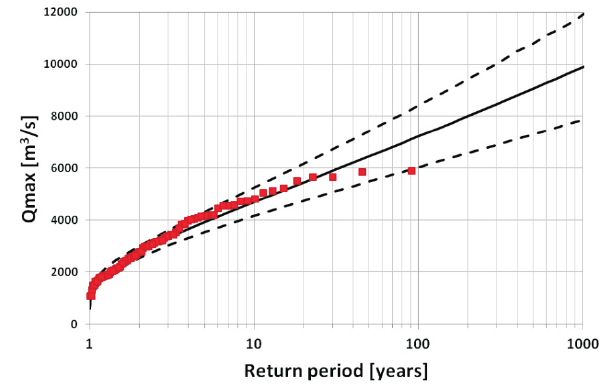
Fig. 2. Comparison of the empirical distribution with a 2-parameter log-normal distribution estimated using the maximum likelihood method for the Warsaw reach; squares represent the empirical distribution, continuous line denotes the estimated theoretical distribution, dashed lines represent 0.95 confidence limits.